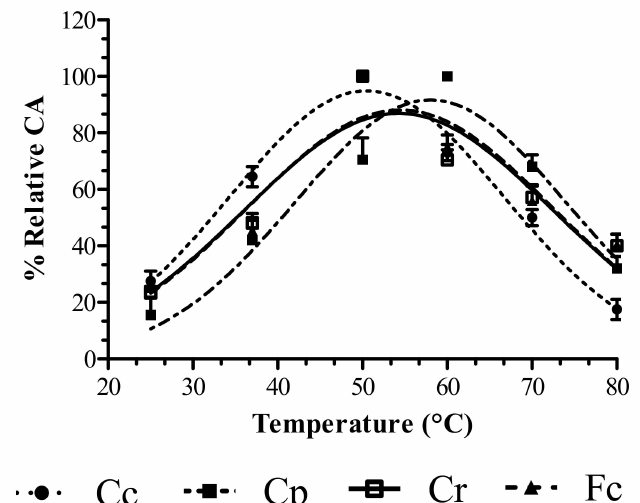
Figure 2. Temperature’s e ff ect on the caseinolytic activities (CAs) of C. cardunculus (Cc), C. papaya (Cp), calf rennet (Cr) and F. carica (Fc) extracts, measured in bu ff er acetate (pH 5.5). The percentages (%) of relative CA represent the means of three independent determinations performed in triplicate for each